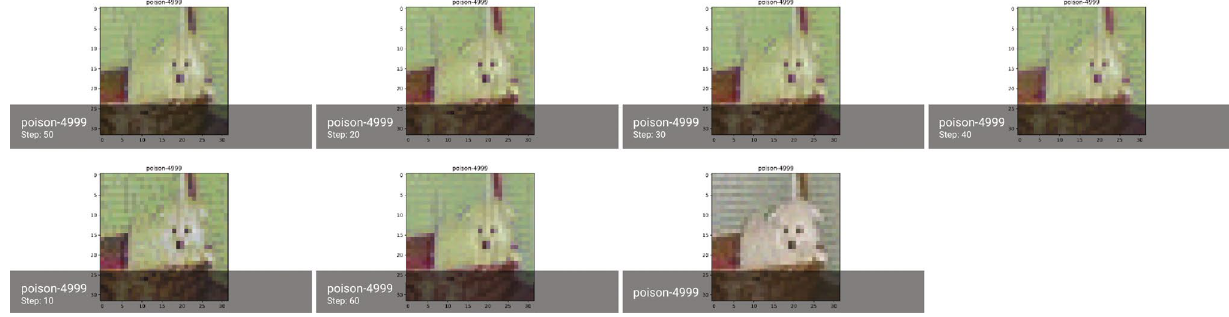
Fig. 4 Poisoned dog images